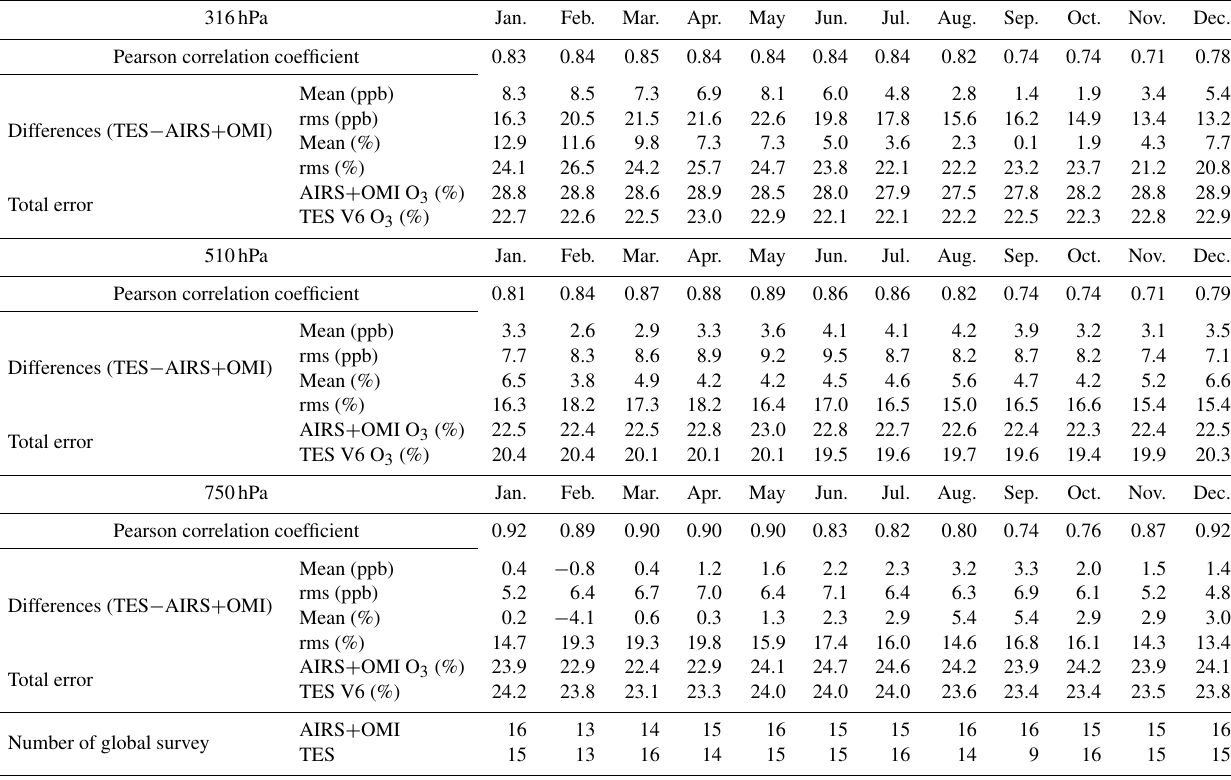
Table 3. Comparisons between joint AIRS + OMI and TES gridded (2 . 5 ◦ × 2 . 5 ◦ ) global survey measurements of ozone concentration at three pressure levels (316, 510, and 750hPa) for the year